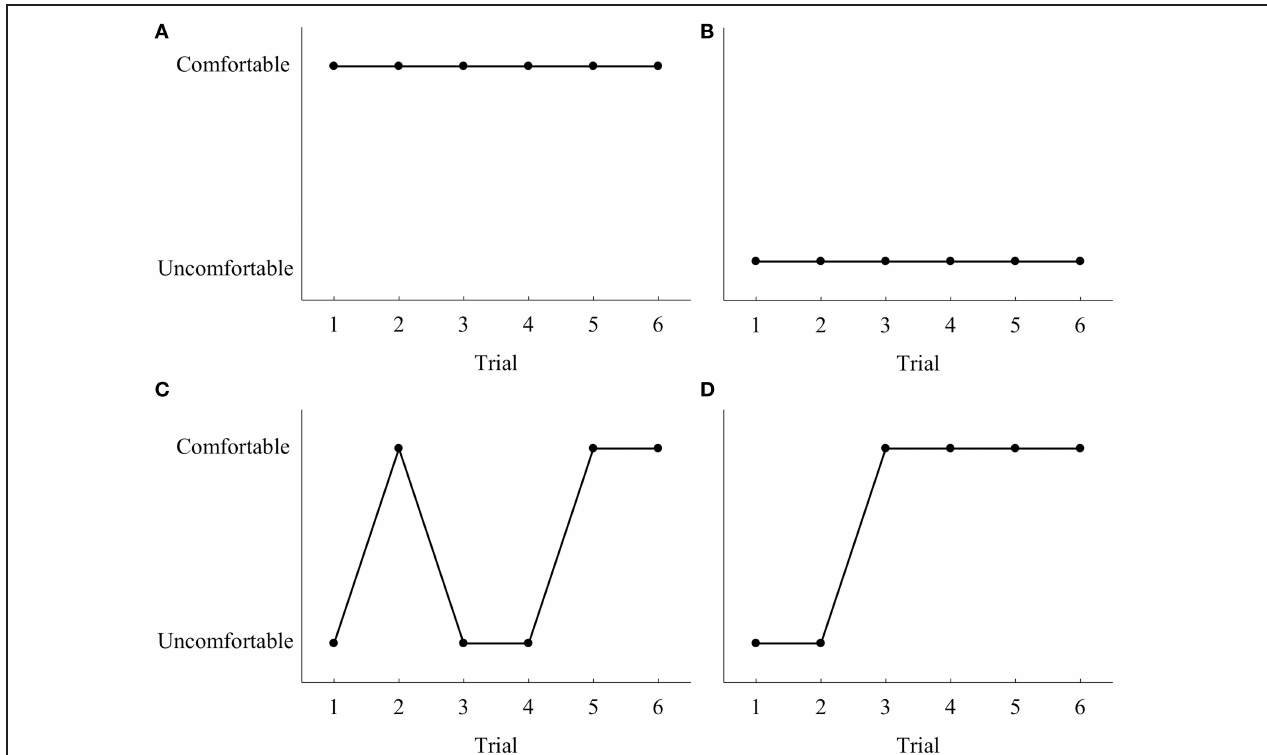
FIGURE 3 | Sample of the four different types of behavior that were evident in our data when the calculator (chosen due to most variability) was placed in a comfortable position relative to the participant for the tool use condition only. (A) The participants gave the tool always in manner that facilitated beginning-state comfort for the confederate for both use and set conditions (2 participants).